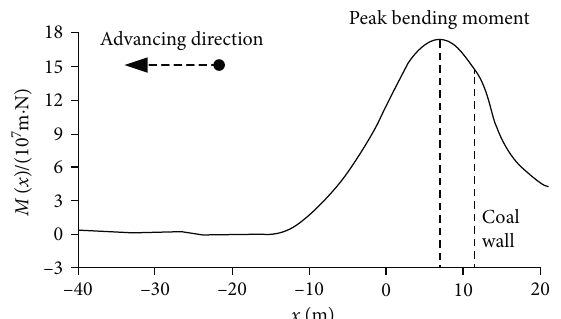
Figure 9: Distribution of overburden bending moment.